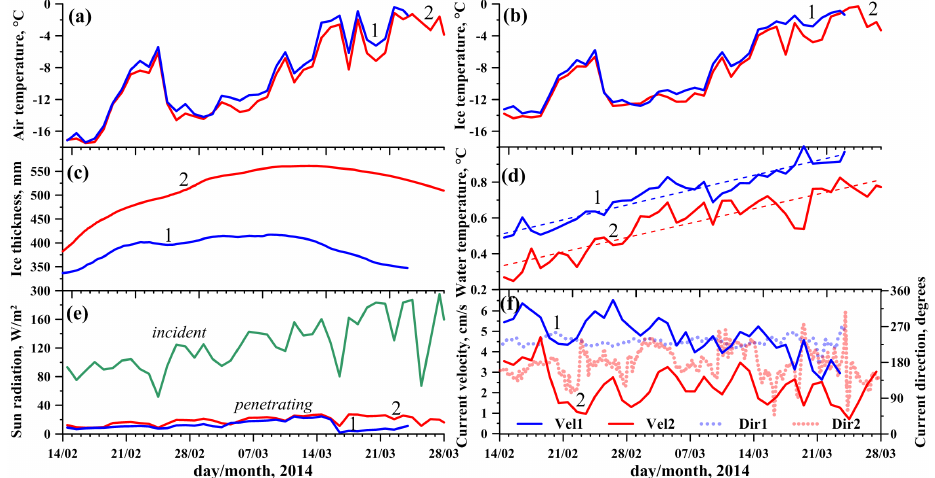
Figure 9. Daily averaged data on the Lake Baikal ice regime during the observations for Station 1 (blue lines) and Station 2 (red lines): ( a ) air temperatures at 1.5 m above the ice, ( b ) temperatures of the ice surface, ( c ) ice thickness, ( d ) water temperatures at 5 m depth and calculated linear trends, ( e ) incident solar radiation and penetrating water (at 1.5 m depth) and ( f ) current velocities and directions at a 1.5 m